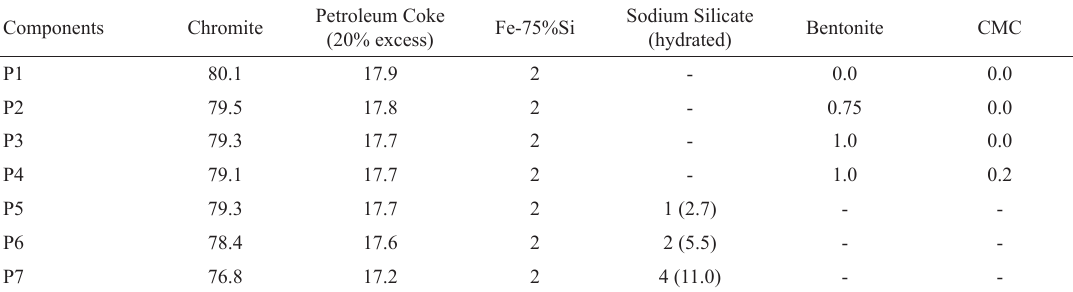
Table 4: Composition of the pellets (wt%)